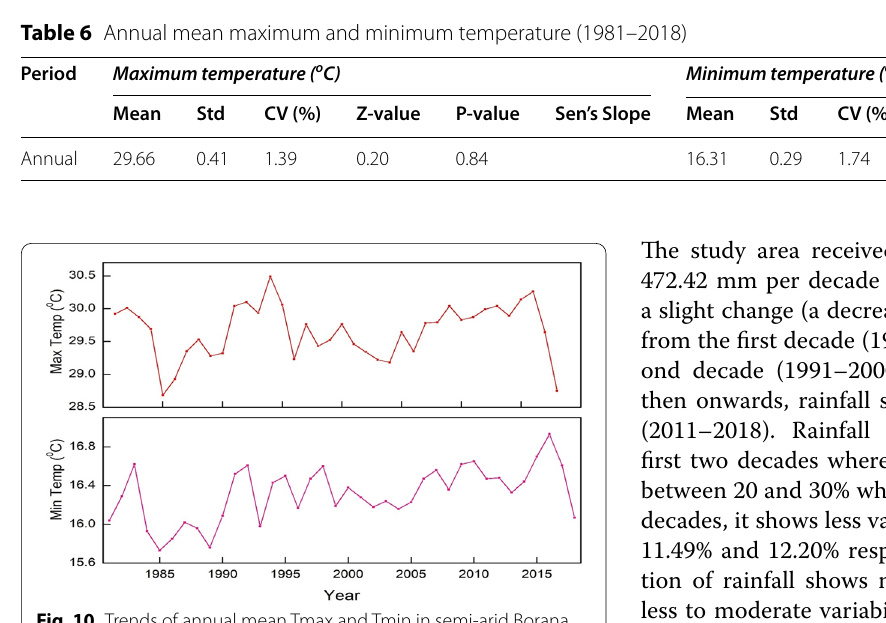
Rainfall distribution at decadal scale is characterized by less variability compared to other timescales in this study.